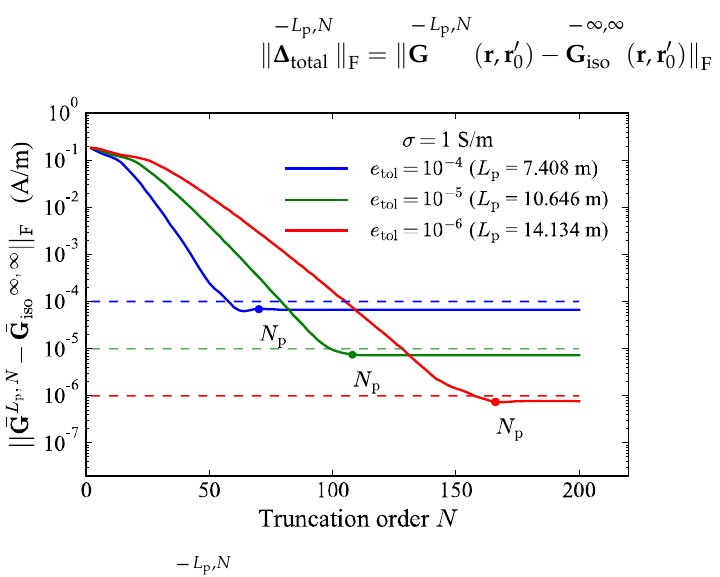
L when the me- p